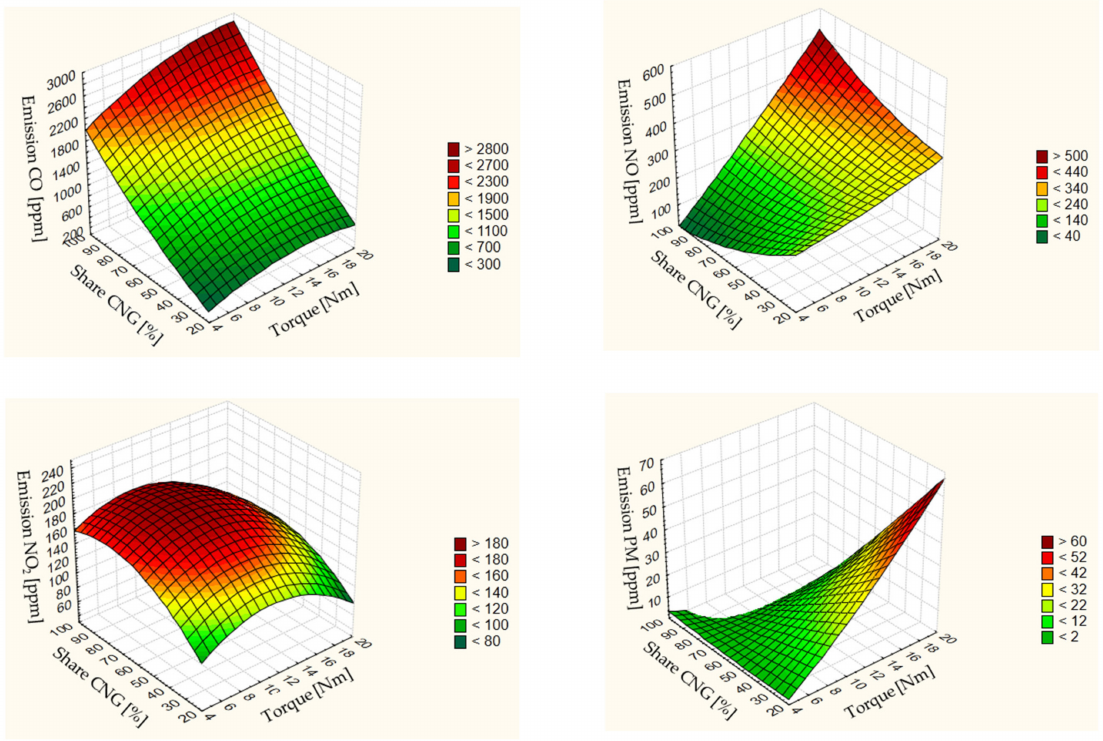
Figure 6. Emission of CO, NO, NO 2 , and PM in the mixture of DF and CNG at variable